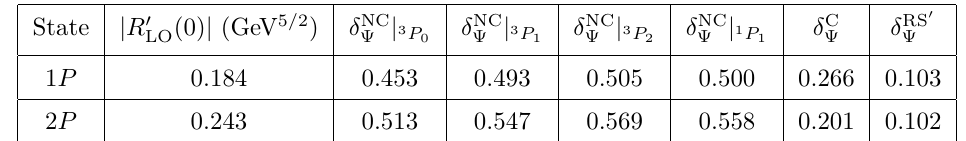
Table 1 . LO wavefunctions at the origin | R 0 (0) | and relative corrections to the wavefunctions at the origin in the MS scheme at scale Λ = m for 1 P and 2 P charmonium states. δ NC from the 1 /m and 1 /m 2 potentials, δ C the RS 0 subtraction term. The δ NC